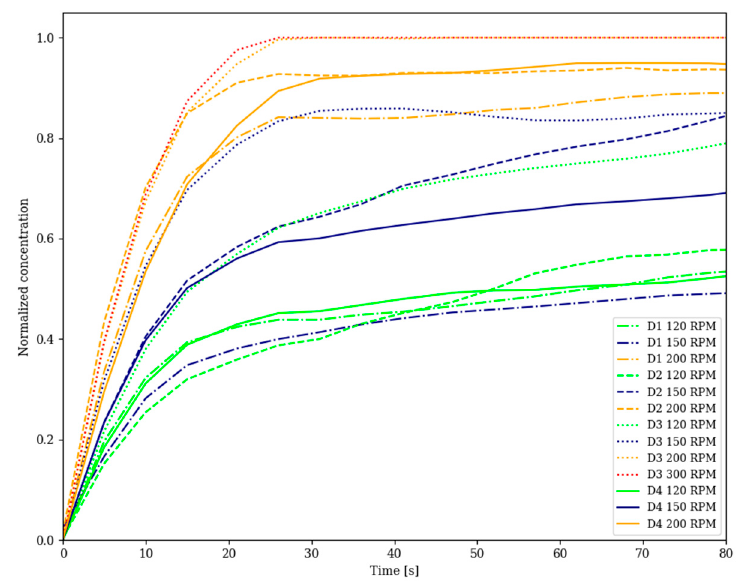
ff erent mixing vessel configurations and di ff erent mixing Figure 5. Dissolution of sucrose at different mixing vessel configurations and different mixing speeds. Figure 5. Dissolution of sucrose at di